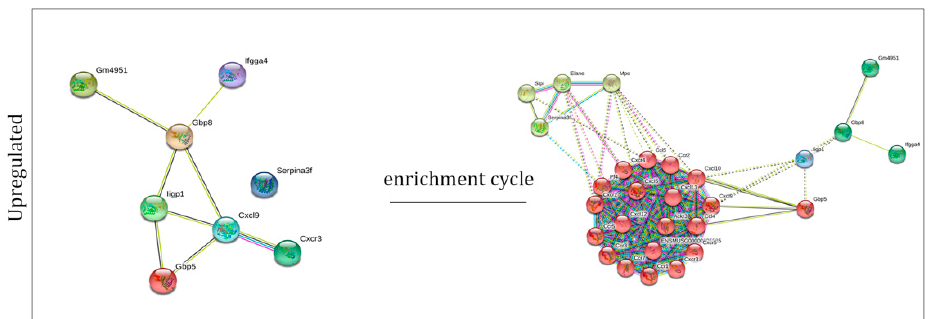
Figure 5. Networks representing the interactions among the proteins corresponding to the selected genes before (left) and after the enrichment procedure (right).